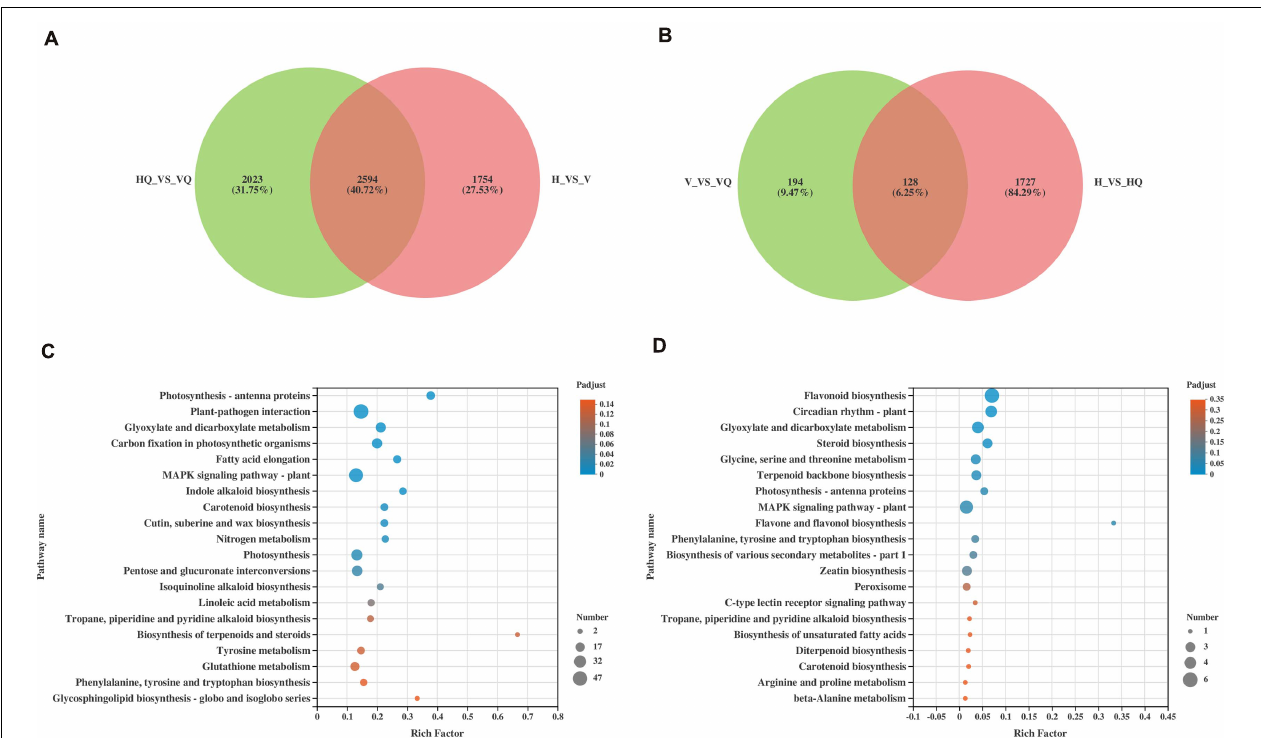
FIGURE 5 | The effects of ToCV and Bemisia tabaci on tomatoes, respectively. (A,B) The Venn diagram of differentially expressed mRNAs. (C) KEGG enrichment analysis of the common differential genes in HQ_vs_VQ and H_vs_V. (D) KEGG enrichment analysis of the common differential genes in V_vs_VQ and H_vs_HQ. H, healthy tomato plants. HQ, tomato plants was fed on by healthy B. tabaci for 24 h. V, tomato plants was inoculated with ToCV. VQ, tomato plants with ToCV that were fed on by healthy B. tabaci for 24 h.